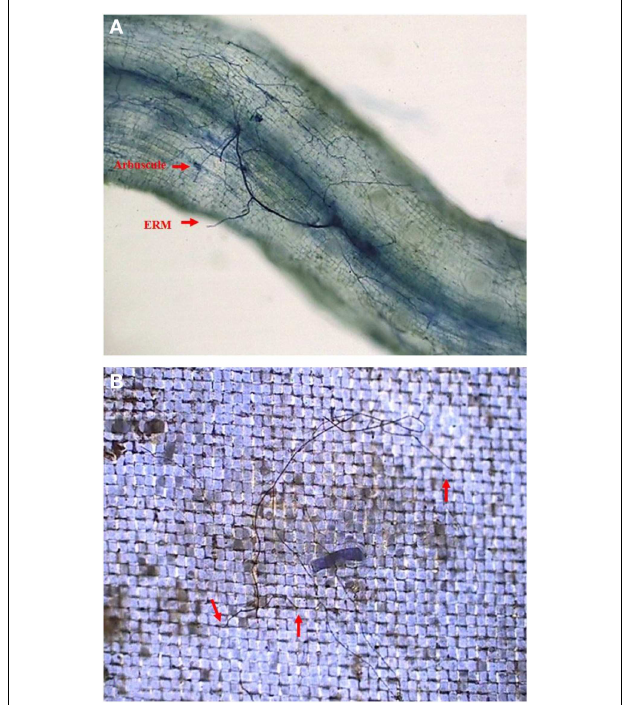
FIGURE 2 | Root mycorrhizal colonization (A) and extraradical mycelium (B, red arrow shows the entry of extraradical mycelium into 37 µ m nylon-mesh) in trifoliate orange ( Poncirus trifoliata ) seedlings inoculated with Funneliformis mosseae and grown in 37 µ m nylon-mesh separated root/hyphae compartments.